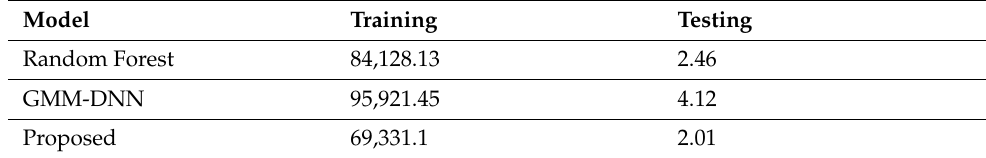
Table 5. Analysis of the model in terms of computational complexity.